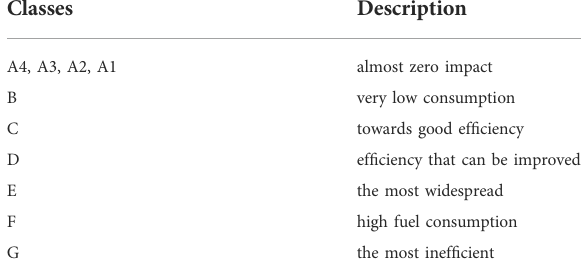
TABLE 4 Description of the “ Classi di ef fi cienza energetica degli edi fi ci ” (Italy).